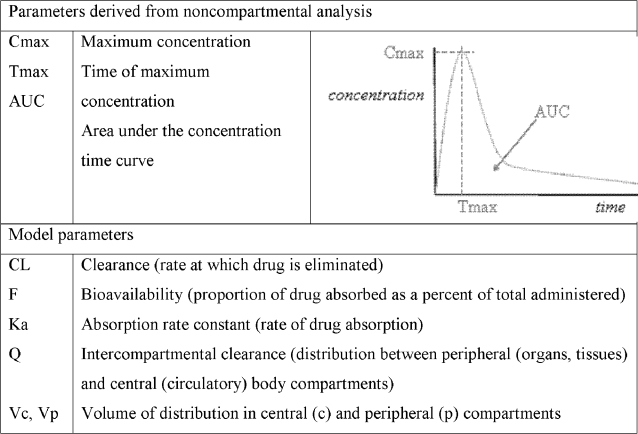
Key pharmacokinetic parameters.